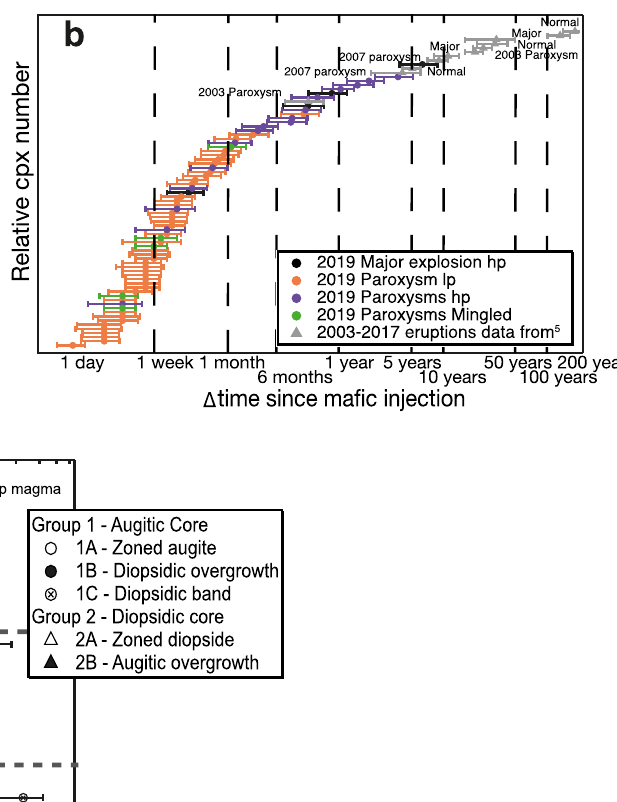
28 August paroxysms hp -magma; green: 3 July and 28 August paroxysms min- gled -magma. Timescales for the 2003 – 2017 eruptive period from Di